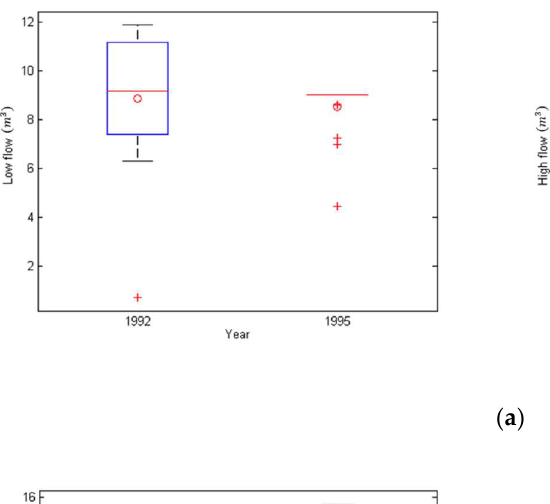
Figure 9. Flow duration curves (FDCs) for the selected pairs: ( a ) 1992 vs. 1995; and ( b ) 1992 vs. 2000. Table 7. Statistical tests for the effect of forest disturbances on the low flows and high flows .